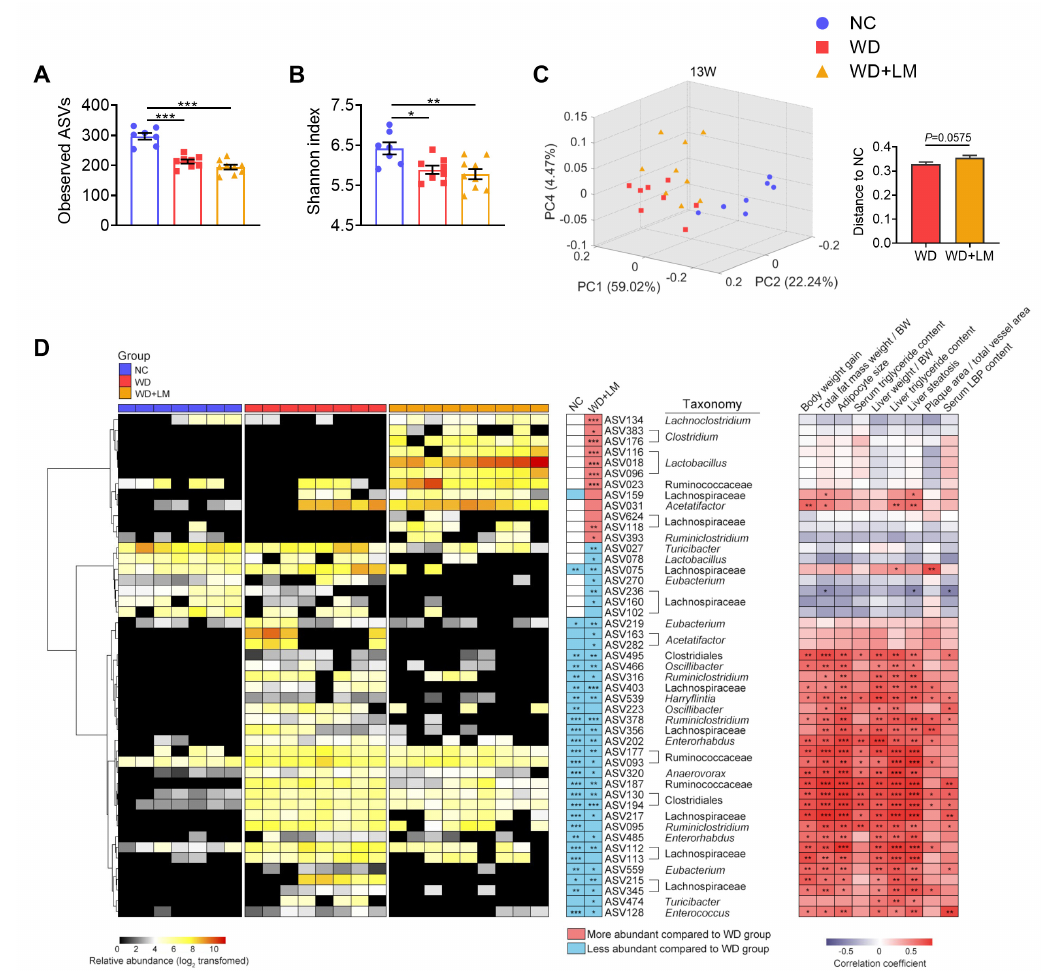
Figure 4. Modulation of gut microbiota in ApoE - / - mice after administration of a Western diet with or without L. mucosae A1 for 13 weeks. ( A ) Amplicon sequence variants (ASVs) richness of gut microbiota. ( B ) Shannon index of gut microbiota. ( C ) Principal coordinate analysis (PCoA) plot of gut microbiota based on weighted Unifrac distance and weighted Unifrac distance from WD group and WD + LM group to NC group. Data for ASVs richness, Shannon index and distance are shown as means ± s.e.m. Number of mice per group: NC: 7, WD: 8, WD + LM: 9. Values for ASVs richness and Shannon index of each group were analyzed by one-way analysis of variance (ANOVA) followed by Tukey’s post hoc test. Values for distance were analyzed by unpaired t -test. * p < 0.05, ** p < 0.01, *** p < 0.001. ( D ) 47 ASVs identified as key variables for di ff erentiation between the gut microbiota of WD + LM group and that of WD group by sparse partial least squares discriminant analysis (sPLS-DA) model (shown in Figure S8). Left, the heatmap represents the normalized and log 2 -transformed relative abundance of the ASVs in each sample. The ASVs were clustered by the ward.D method. Middle, the changing direction of 47 ASVs in NC group and WD + LM group compared to WD group according to sPLS-DA models (shown in Figures S7 and S8). Redness and blueness indicate the relative abundance of ASVs were more and less, respectively, compared to WD group. The relative abundance of key ASVs were compared between groups by Mann–Whitney U test. * p < 0.05, ** p < 0.01, *** p < 0.001. Right, Spearman correlations between the host parameters related to lipid metabolism as well as atherosclerosis and the relative abundance of 47 ASVs. Colors red and blue denote positive and negative association, respectively. The intensity of the colors represents the degree of association between the abundances of ASVs and host parameters. p values of spearman correlations were adjusted by false discovery rate (FDR). * adjusted p < 0.05, ** adjusted p < 0.01, *** adjusted p < 0.001. The genus-level taxonomic classifications of the ASVs are shown. For all the figures, NC: n = 7, WD: n = 8, WD + LM: n =